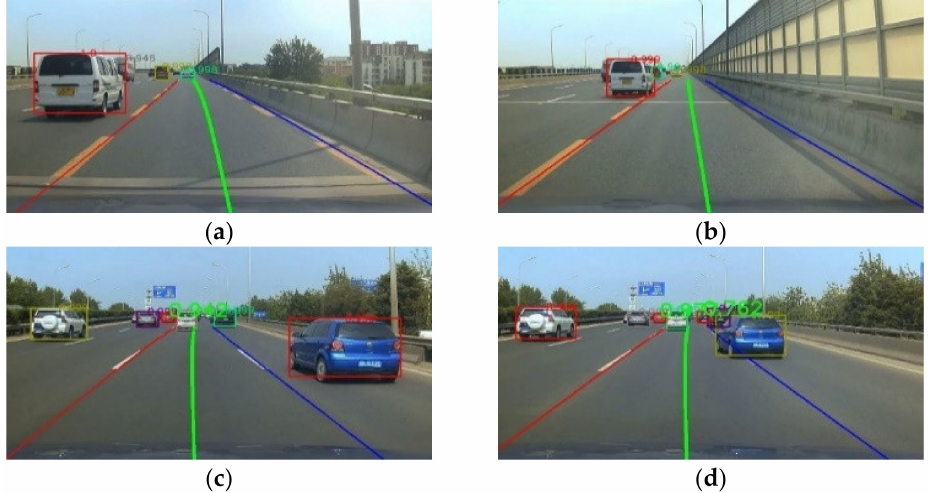
Figure 12. Selection of vehicle observation points.( a ) detection result of the white van. ( b ) detection result of the white van. ( c ) detection result of the blue vehicle. ( d ) detection result of the blue